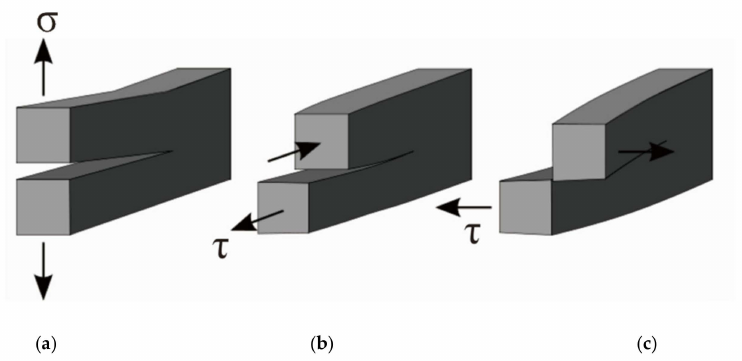
Figure 2. Three basic fracture modes of loading for a crack, σ is the normal stress and τ is the shear stress. ( a ) Mode I, ( b ) Mode II, and ( c ) Mode